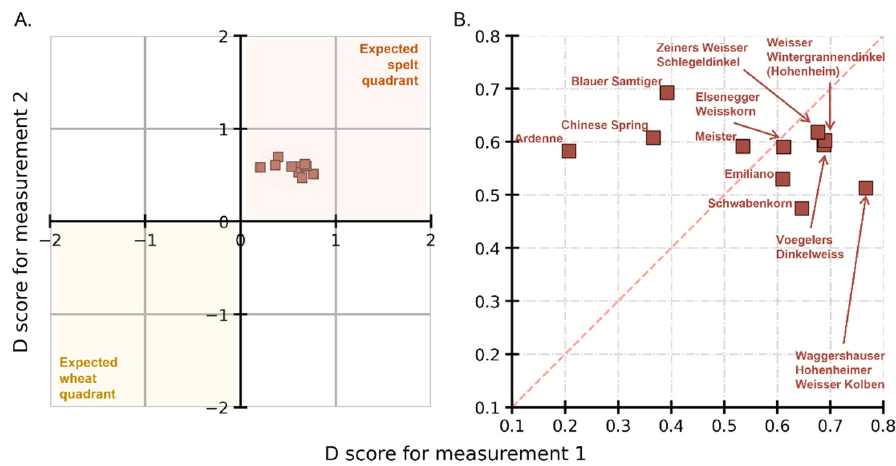
Figure 4. Youden plot showing the D scores for untypical spelt cultivars ( A ) with the magnified section in ( B ). Untypical spelt (brown squares) with their corresponding names, shown to be correctly predicted as spelt.